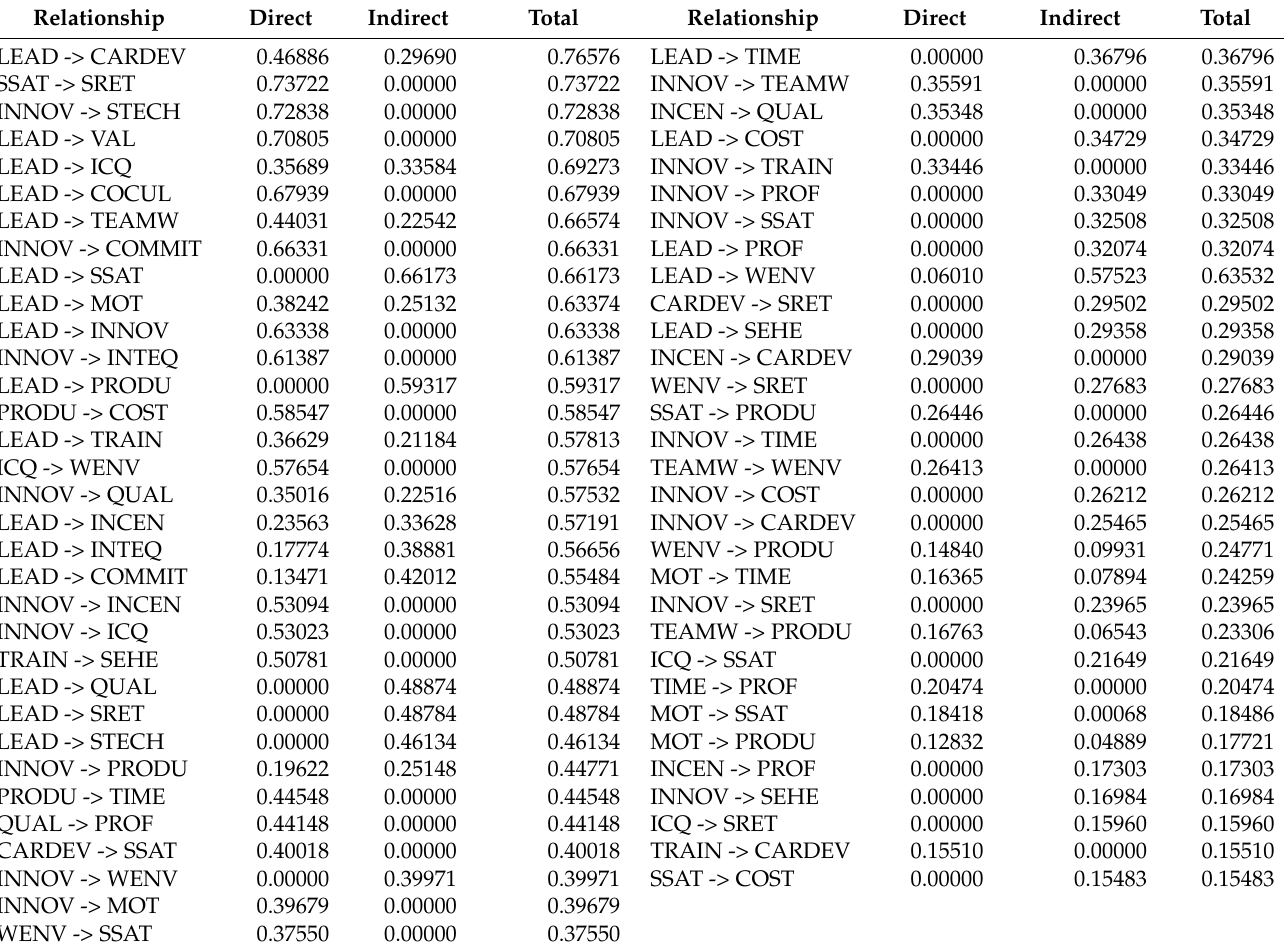
Table 8. Most relevant HR factors that affect each other according to Total Effects greater than